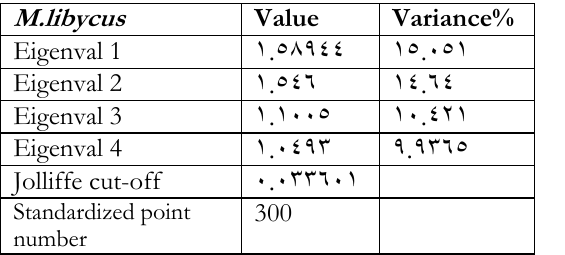
TABLE3: Eigenvalues and each portion in total variance of eigenshape analysis of two parts of meatus in M.persicus and